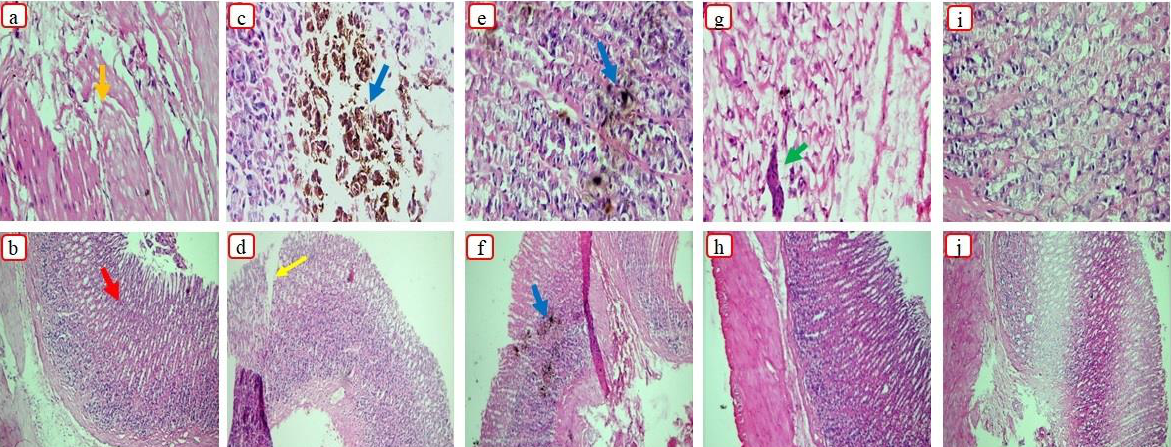
Figure 9. Histological presentation of rat’s stomach in the ( a , b ) control, ( c , d ) Dex, ( e , f ) S1, ( g , h ) S18, and ( i , j ) S23 groups. Here, the orange arrow indicates the mucosa, the red arrow indicates gastric pits, the blue arrow indicates necrotic lesions, the yellow arrow indicates the damaged epithelium, and the green arrow indicates fibrin deposition.